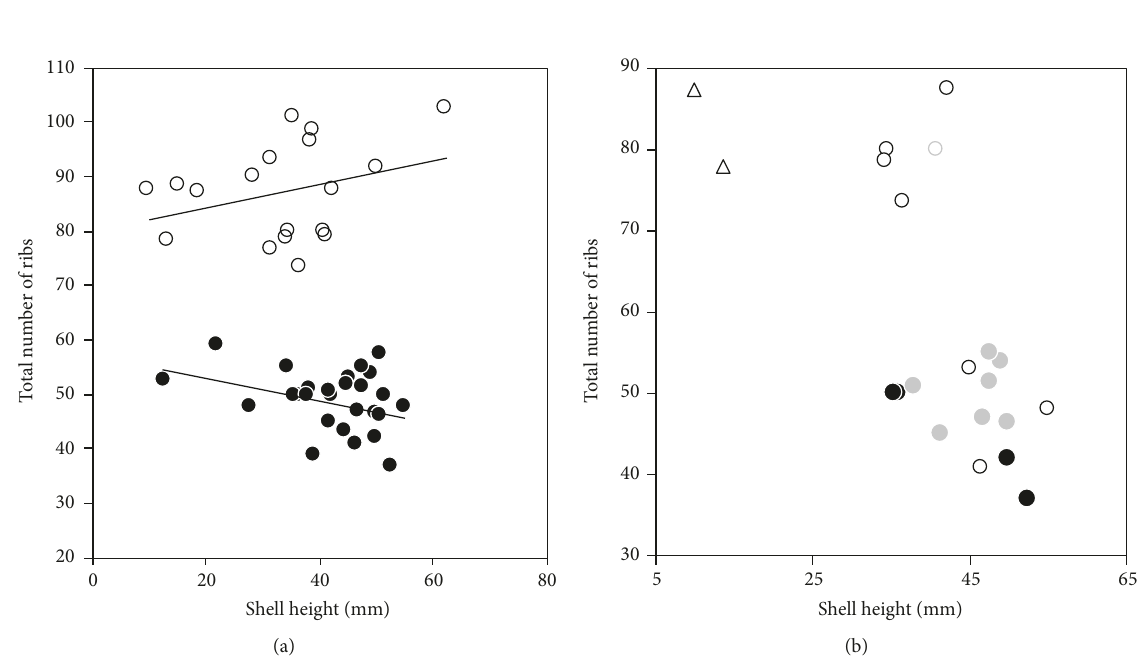
Figure 4: (a) Relationships between shell rib numbers and shell height. Black dots represent individuals belonging to the Ctenoides scaber clade and open circles represent those from the C. mitis clade. The distributions are significantly different ( 𝑃 < 0.00001 ). (b) Number of shell ribs versus shell height for individuals with tentacle color information available. Red, white, striped, light orange, and banded tentacles are represented by black dots, open circles, grey dots, grey open circles, and triangles,